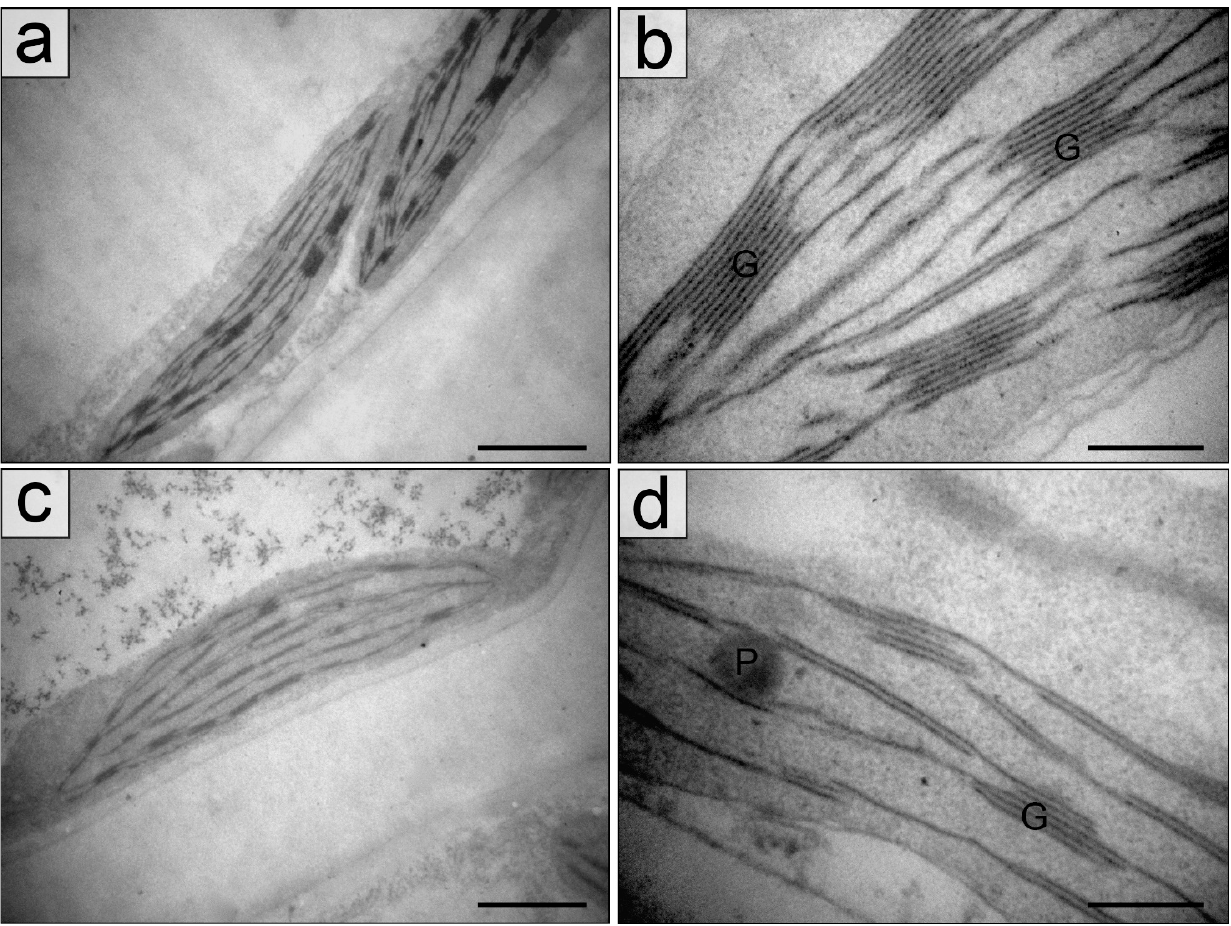
Figure 4. General view of chloroplasts ( a , c ) and chloroplast fragments with grana consisting of different number of thylakoids ( b , d ) from palisade parenchyma cells of young leaves of Hydrocharis morsus-ranae in the shade ( a , b ) and in the sun ( c , d ). Abbreviations: G—granum. Scale bar: ( a , c )—1 µm, ( b , d )—0.2 nm.